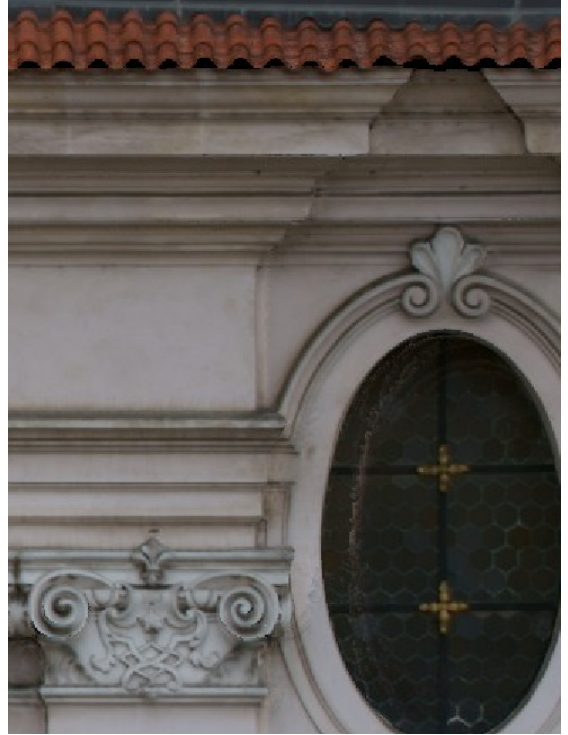
Figure 9. Average orthophoto detail